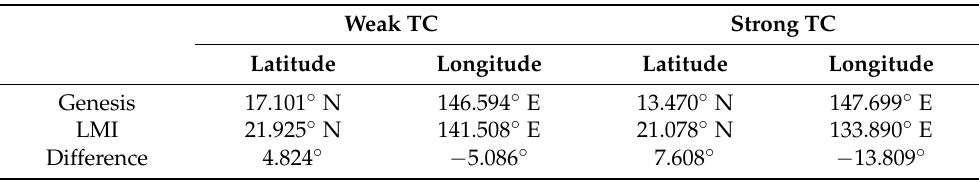
Figure 2. Box-and-whisker plots of ( a ) distance (km) and ( b ) interval (hour) between locations of TC genesis and LMI over the WNP grouped by LMI level (yellow for TD/TS, orange for minor TC, and red for major TC). Boxplot displays median (horizontal black line near box center), interquartile range (box perimeter; [ q 1 , q 3 ]), whiskers (black lines; [ q 1 – 1.5 ( q 3 – q 1 ), q 3 + 1.5 ( q 3 – q 1 )]), and outliers (rhombic points). The red horizontal line in ( b ) is a reference for the interval of 48 h. Table 2. Mean genesis and LMI locations of TCs and differences in two categories. All differences of averages are significant at a confidence level of 99%.